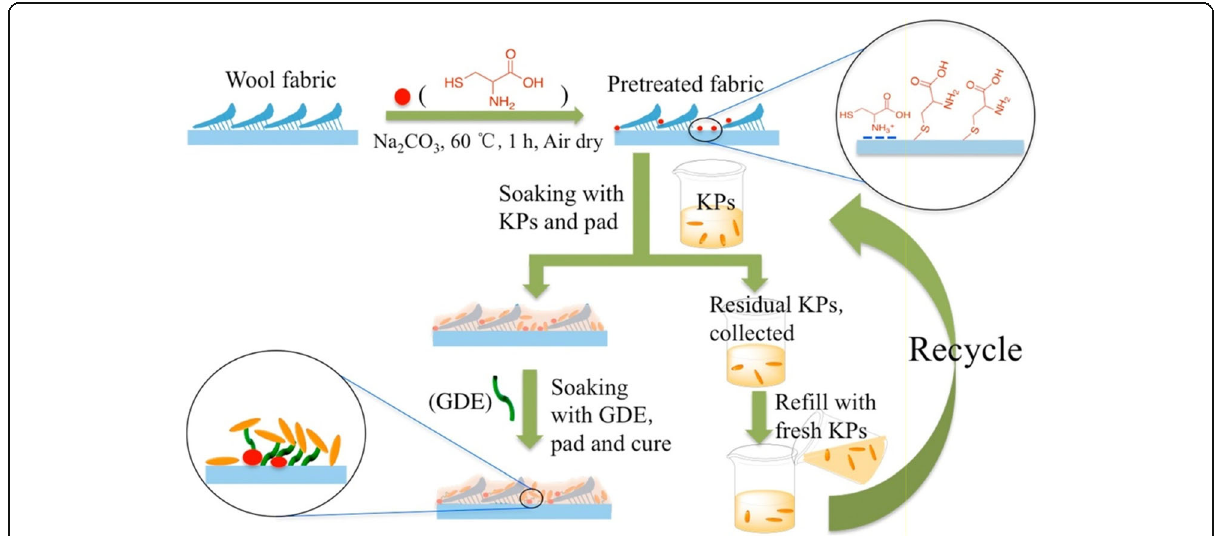
Fig. 7 Schematic diagram for the anti-felting treatment of the wool fabric and recycle use of the extracted keratin polypeptides [51]. Reprinted with permission from Reference [51]. Copyright 2020,